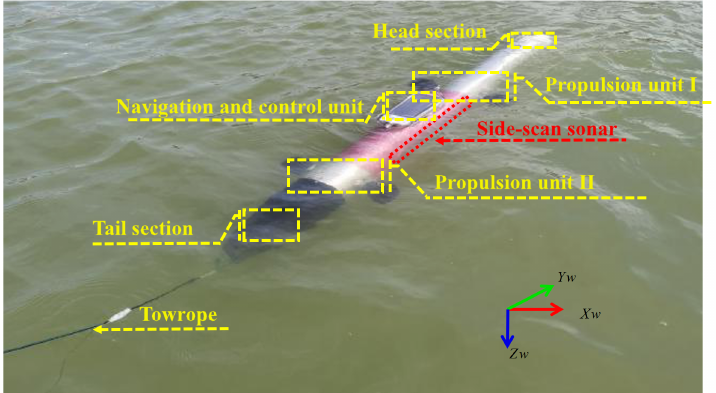
Figure 7. Overall structure of AUV. The AUV consists of seven parts: head section, side-scan sonar, navigation and control unit, propulsion unit I, propulsion unit II, tail section, and towrope.